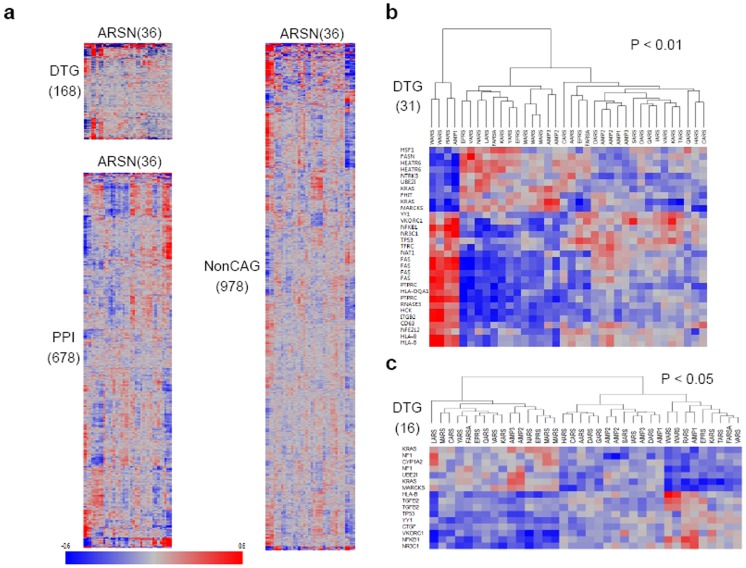
Correlation patterns of 23 ARSs and AIMPs to three different genesets.(a) We identified 846 resulting probe sets including 168 DTGs and 678 PPIs that can directly interact with ARSN using 254 GBM affymetrix U133plus2 microarray dataset in TCGA. For the comparison, we also selected 978 probe sets among 1874 nonCAGs. To understand ARSN-DTGs/PPIs/nonCAGs interactions and visualize the relationship between genesets, a correlation map was made on the basis of their correlation levels with each set. The probe sets are presented in matrix format, where rows represent individual genes of DTGs, PPIs, and nonCAGs, respectively, and columns represent each gene of ARSN. Each cell in the matrix represents the correlation level of a gene in an ARSN. Red color indicates that the gene tends to be up or down-regulated together; Blue color indicates the opposite tendency (The darker, the stronger the association between two genes). (b) Hierarchical clustering analysis showed that ARSN were shared by three groups with 31 DTGs (FDR <0.005). 31 DTGs were generated on a supervised hierarchical clustering analysis. (c) Hierarchical clustering of ARSN based on the 16 DTGs based on nonlinear association between two gene expression sets. 16 DTGs were correlated with three subgroups of ARSN.